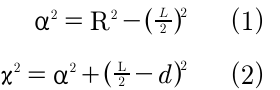
of the radius as 15 mm and the plane created with a length of 4 mm, was possible to calculate the depth (distance from